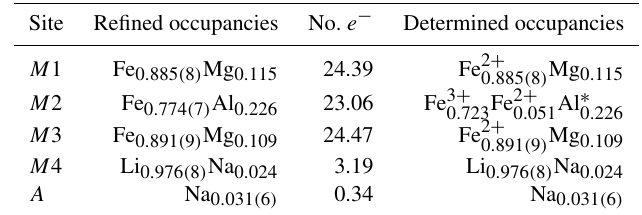
Table 6. Site occupancies of